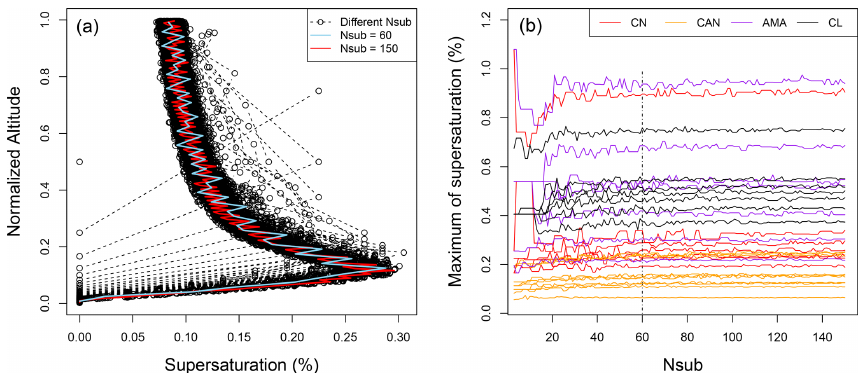
Figure 8. (a) Vertical profiles of the simulated supersaturation for different N sub (1–150) in the QDGE scheme for cloud case CN01. (b) Changes of the maximum supersaturation with different N sub for all cloud cases in the four